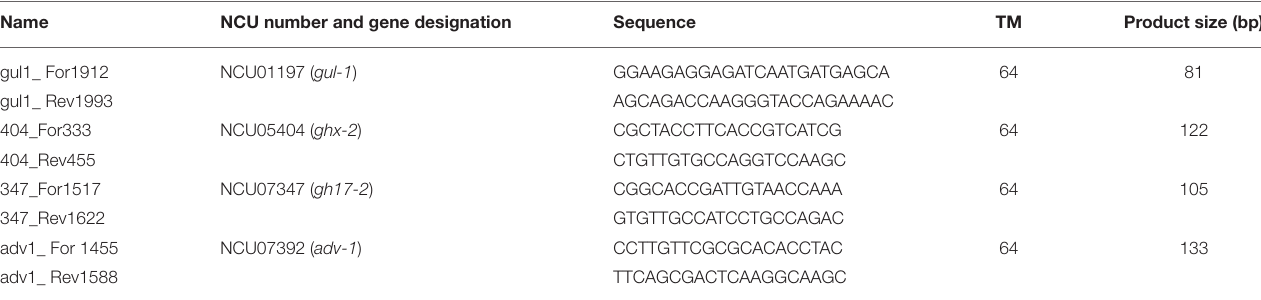
TABLE 2 | Primers used for RT PCR